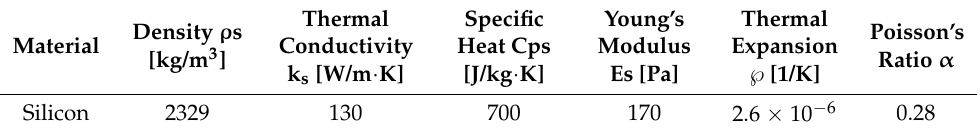
Table 2. The thermo-physical properties of heat sink material.